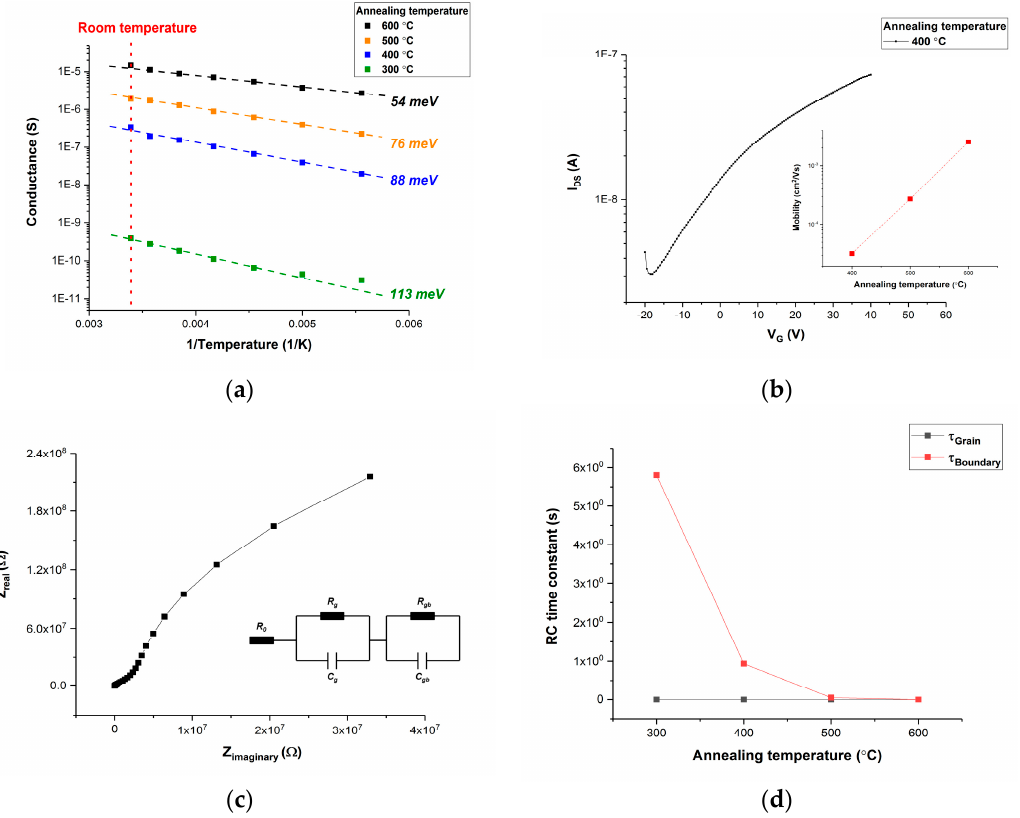
Figure 5. ( a ) Arrhenius plot of ZnO NP thin film annealed at 300 °C, 400 °C, 500 °C, and 600 °C for 3 h in air. ( b ) The transfer function of ZnO NP thin film transistor and field-effect mobility of ZnO NP